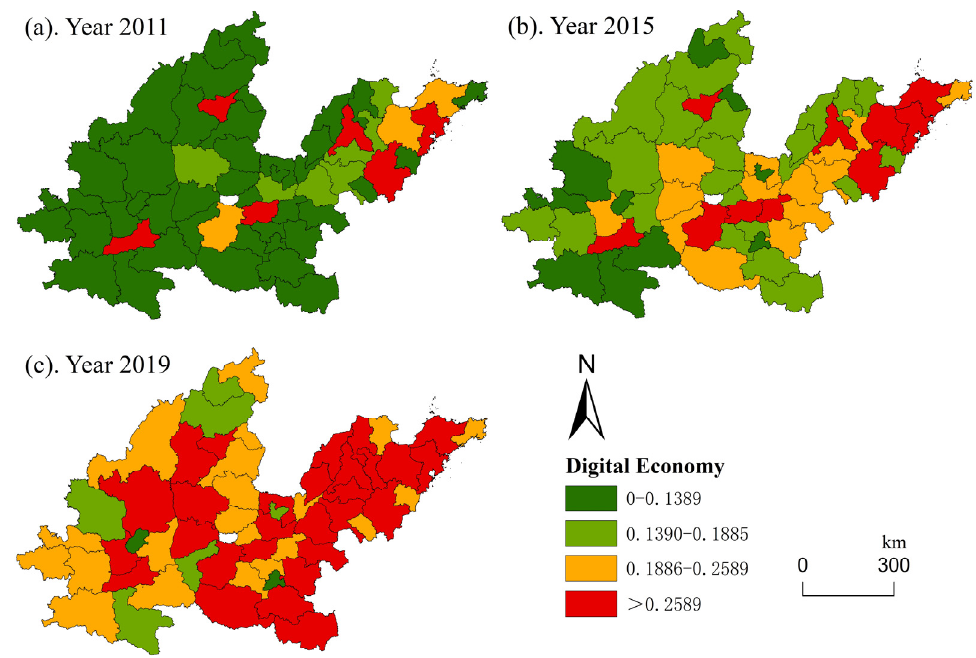
Figure 3. Spatial distribution of the digital economy level.